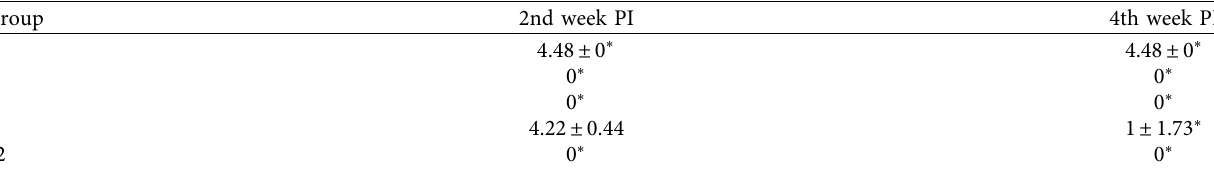
Table 6: Statistical analysis of total Salmonella Enteritidis total count in groups challenged with SXT (log of mean ± SD).